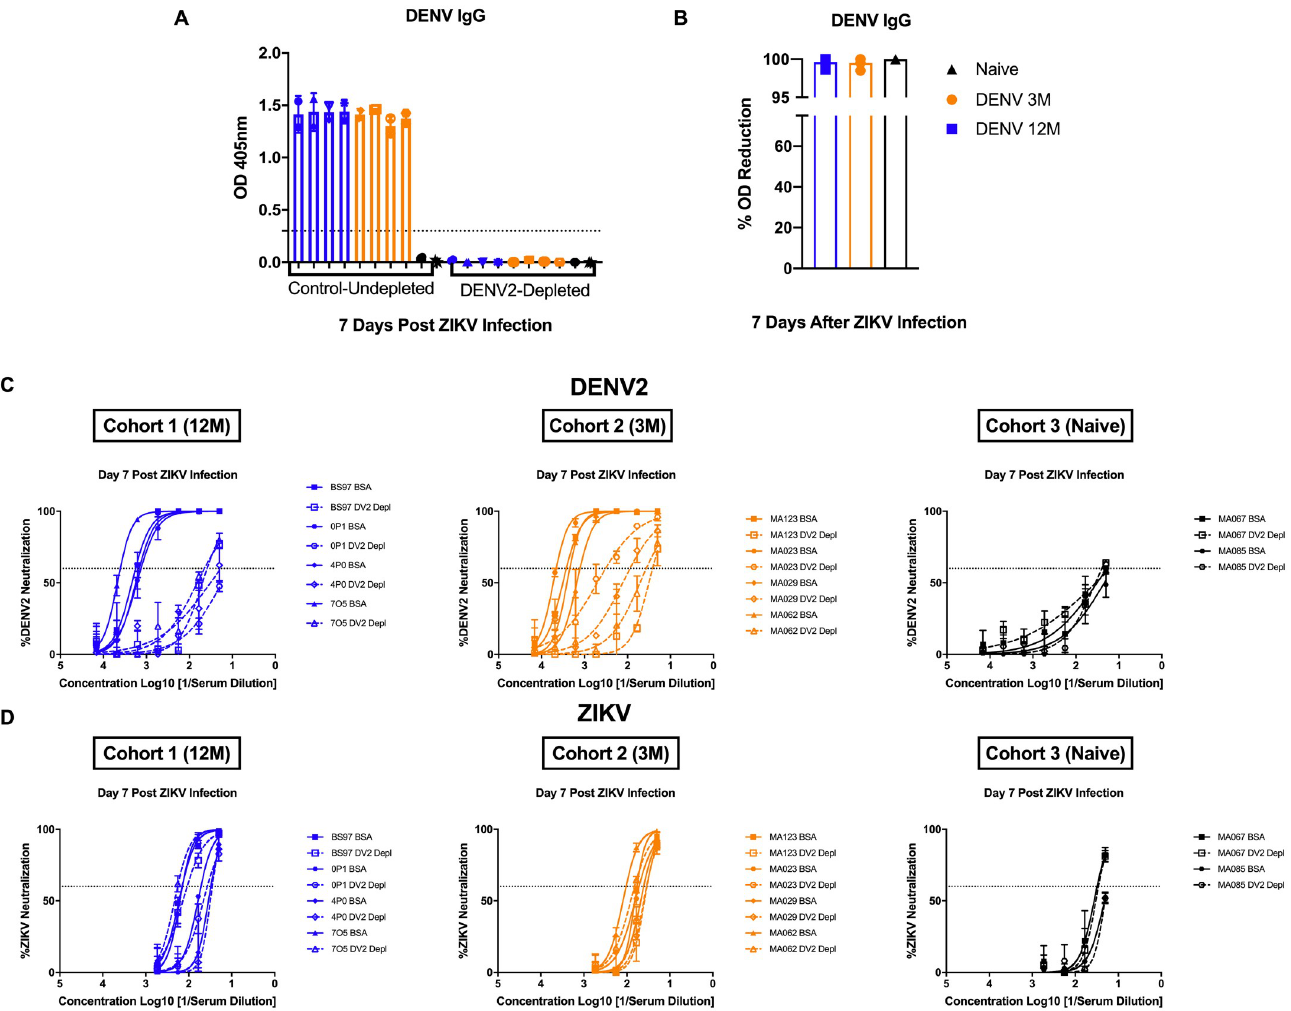
Fig 4. Pre-existing DENV-2 antibodies have no effect on early ZIKV neutralization. Depletion of DENV-2 specific antibodies and its effect on neutralization against DENV-2 and ZIKV is shown. Animals from cohort 1 are shown in blue, animals from cohort 2 are shown in orange and na ï ve animals from cohort 3 are shown in black in all panels. Dotted line indicates the limit of detection for the assay. Open and closed symbols represent control (undepleted) and depleted samples respectively. (A) Confirmation of DENV-2 antibody depletion by ELISA measuring DENV-IgG binding. (B) Depletion percentage of tested sera shown as optical density (OD) reduction difference between control and depleted samples. (C) DENV neutralization titers of depleted and control sera from day 7 after ZIKV infection are shown. (D) ZIKV neutralization titers of depleted and control sera from day 7 after infection are shown. Due to limited amount of serum, only 4 animals from the DENV-12M group and 2 animals from the na ï ve group were chosen for serum depletions.